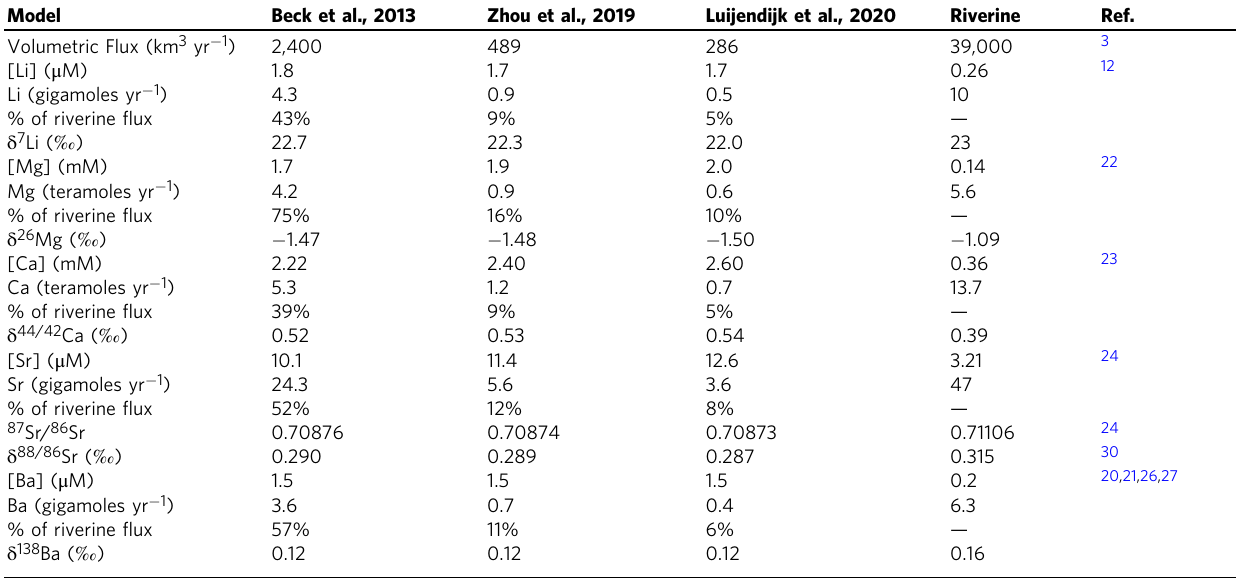
Table 1 Chemical composition and fl uxes.